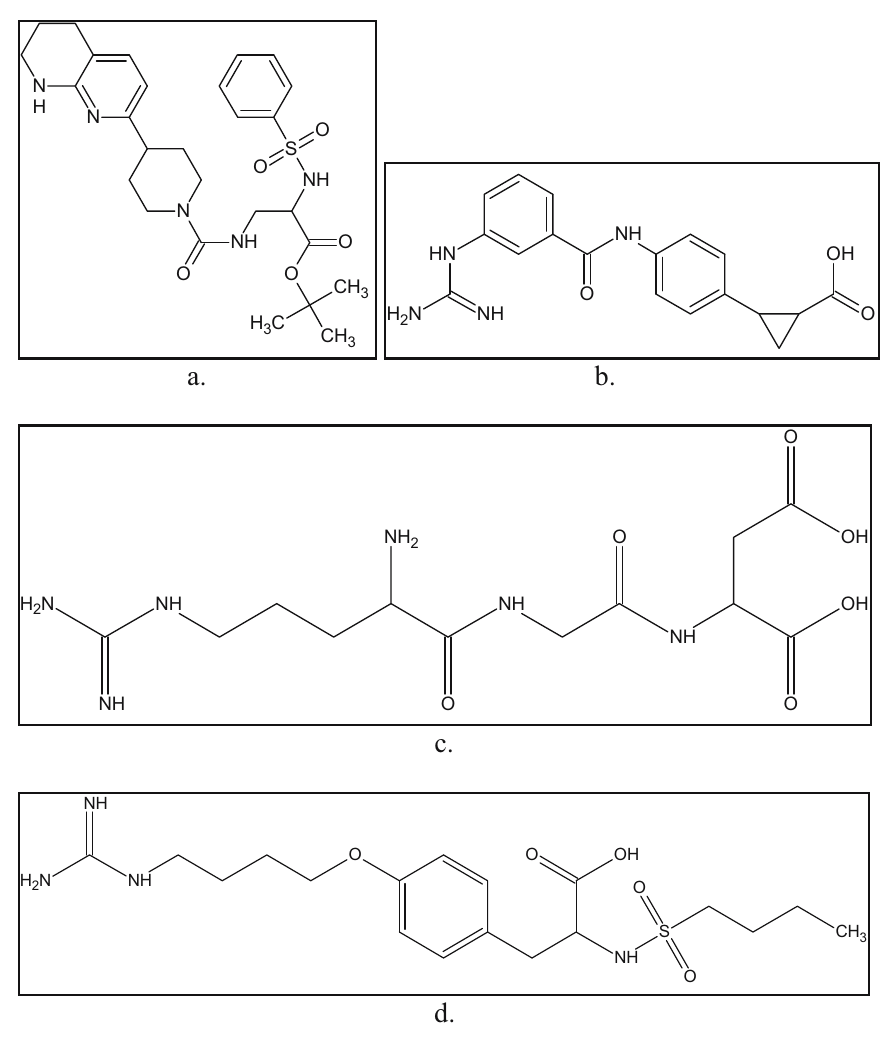
Figure 4: Major ανβ 3 antagonists; ( a ) Merck & Co, patent WO 9818461 - A1: 4 -( δ - 6,7,8 - tetrahydro -[ l,8 ] naphthyridin - 2 - yl ) piperidin - l - yl - carbonyl - 2 -( S )- phenylsulfonylamino - β - alanine - t - butylester; ( b ) searle, patent WO 9736858 - A1: 2 -[ 3 -[[[[ 3 -[( amino - imino methyl )- amino ] phenyl ] carbonyl ]- amino ] methyl ] phenyl ]- cyclopropane carboxylic acid ( tri fl uoro acetate salt ) ; ( c ) Merck KGaA, patent DE 19548709 - A: 2 ( S )- 2 -[[ 2 -[[( 2 S )- 2 - amino - 5 -( diamino methylidene amino )] amino ] acetyl ] amino ] butanedioic acid; ( d ) ( S )- 2 - butylsulfonamido - 3 -[ 4 -( 3 - amino - propoxy ) phenyl ]- propionic